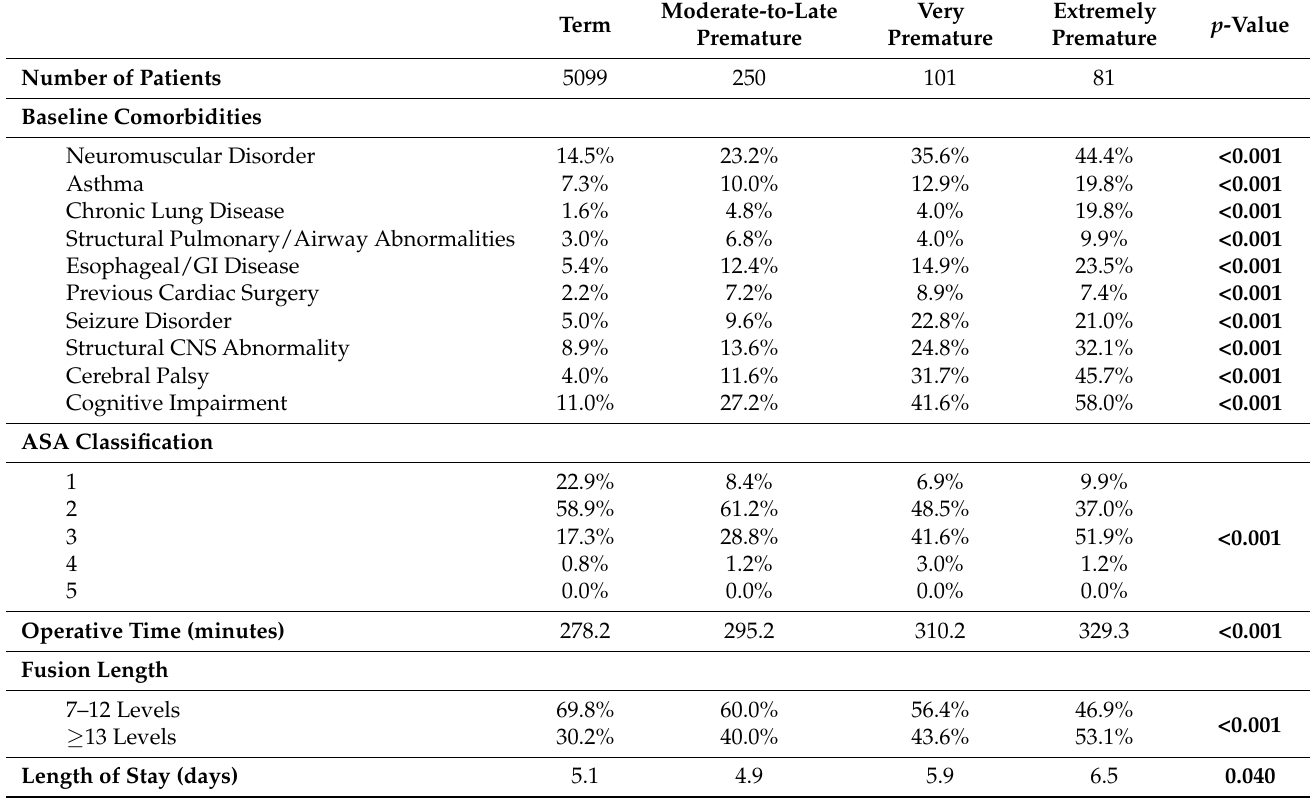
Table 4. Baseline comorbidities, hospital parameters, and outcomes across term ( ≥ 37 weeks), and moderate-to-late prematurity (MLP, 32 ≤ x < 37 weeks), very premature (VP, 28 ≤ x < 32 weeks), and extremely premature (EP, <28 weeks). Bold values are statistically significant ( p <